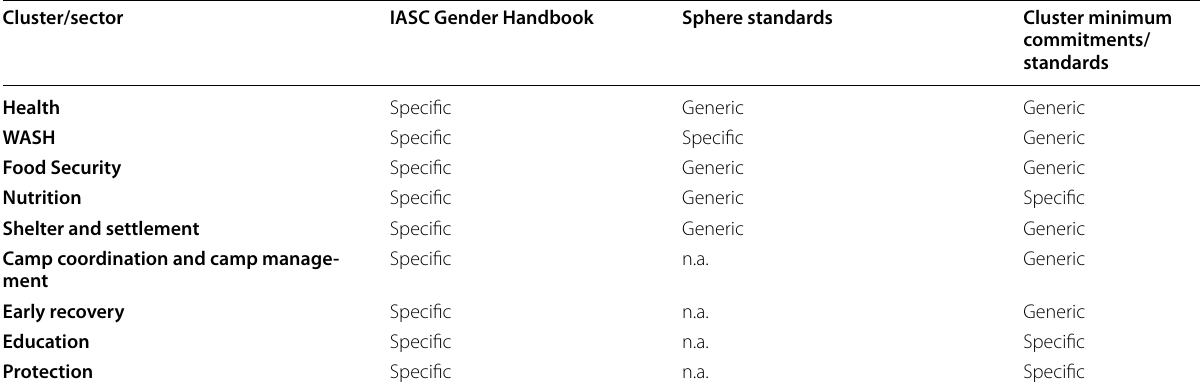
Table 4 Analysis of quality of gender equality guidance in humanitarian resources, standards, and minimum commitments for key